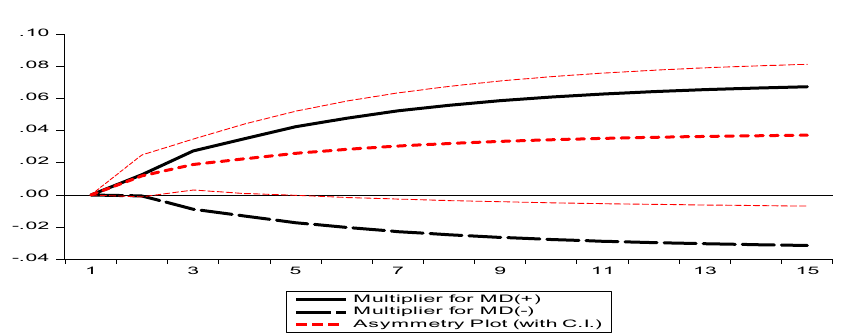
Fig. 5 NARDL dynamic multiplier graph for MD (Source: authors’ illustration from UNDP, WDI, and ETH Zurich KOF data)